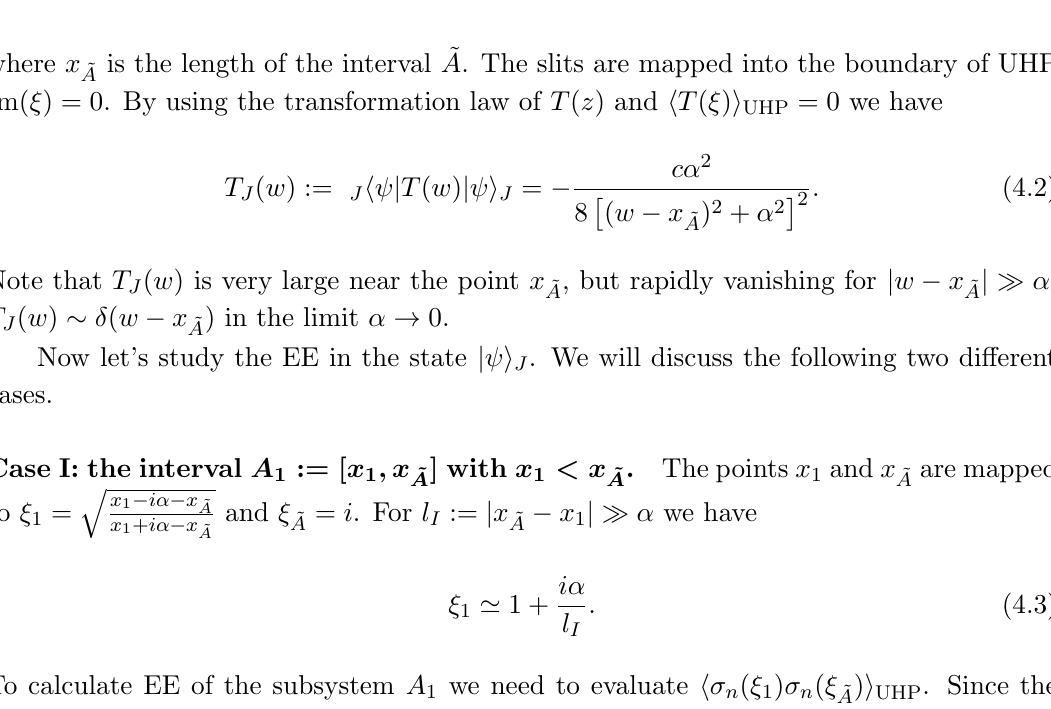
Figure 2 . Path-integral representation of the state j i J